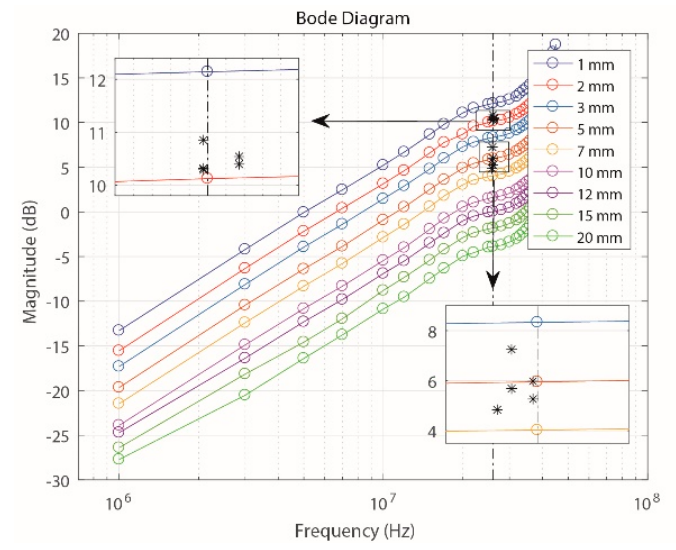
a values of 2 mm and